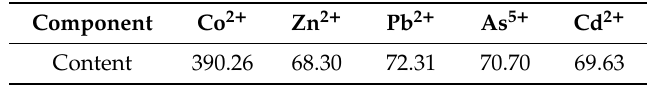
Table 1. The contents of the main toxicant heavy metals in the tailings (units: mg/kg). Component